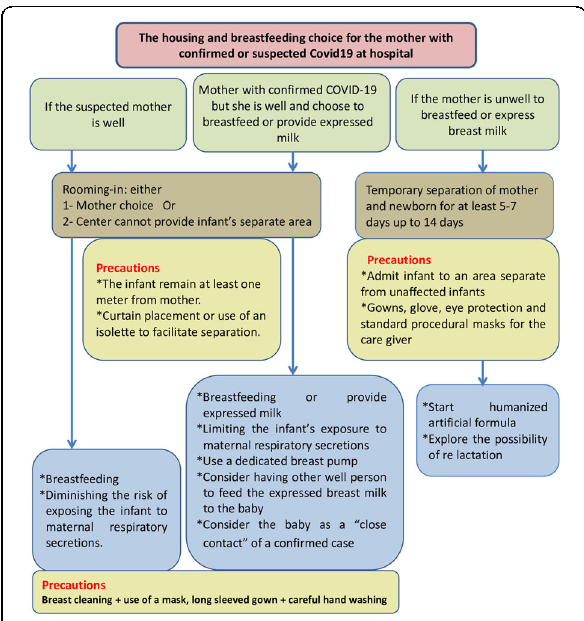
Algorithm 4 The housing and breastfeeding chioce for the mother with confirmed or suspected COVID-19 at